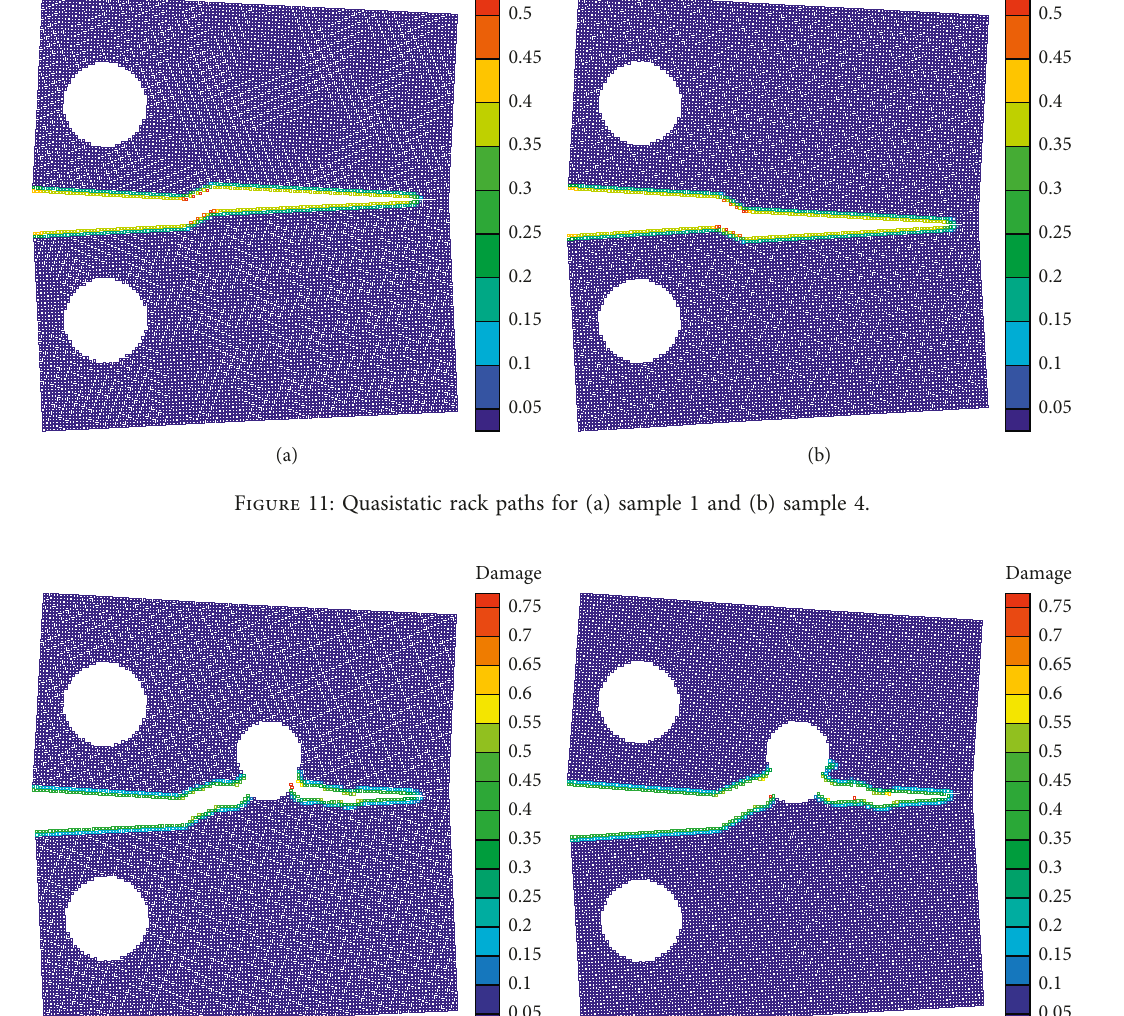
c , s Y and s 0 , (b) m 2 , and (c) A 2 .